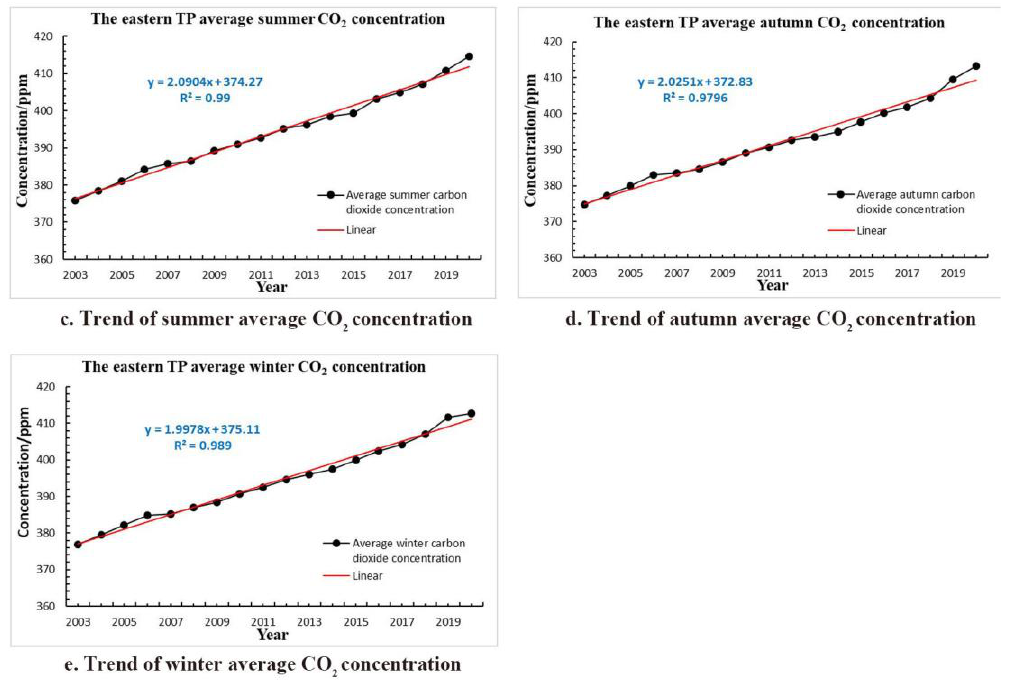
Figure 2. Trend of average CO 2 concentration over the eastern TP during 2003–2020 in ( a ) annum; ( b ) spring; ( c ) summer; ( d ) autumn, and ( e ) winter.